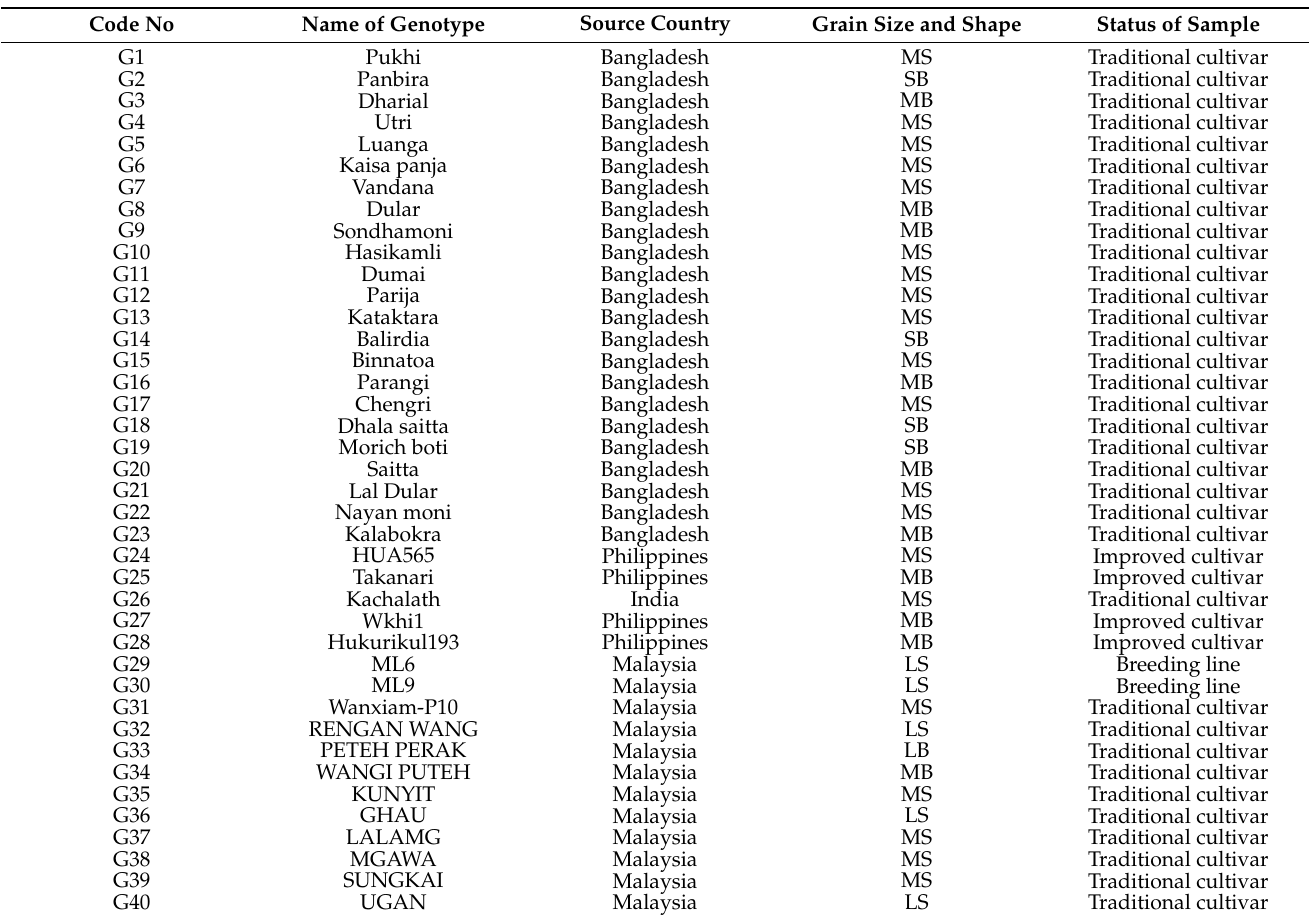
Table 1. Name, origin, grain size, shape, and status of sample of 64 traditional and improved rice genotypes. Code No Name of